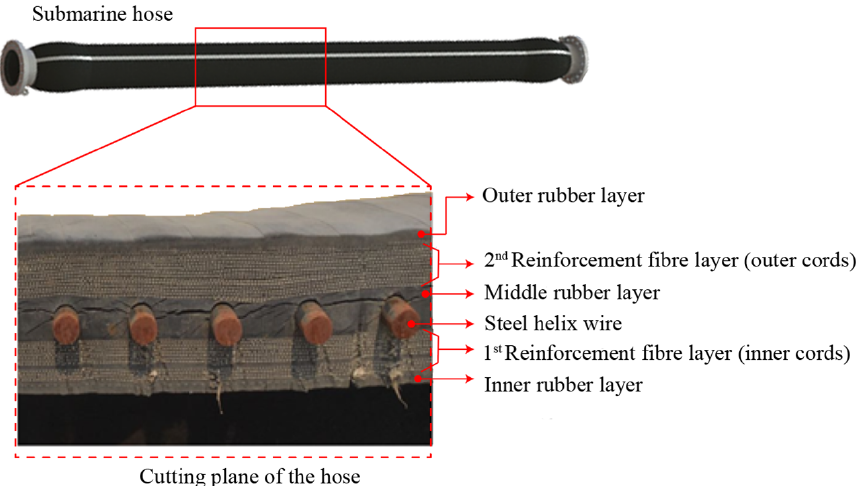
Figure 2. Submarine hose and the cross section.